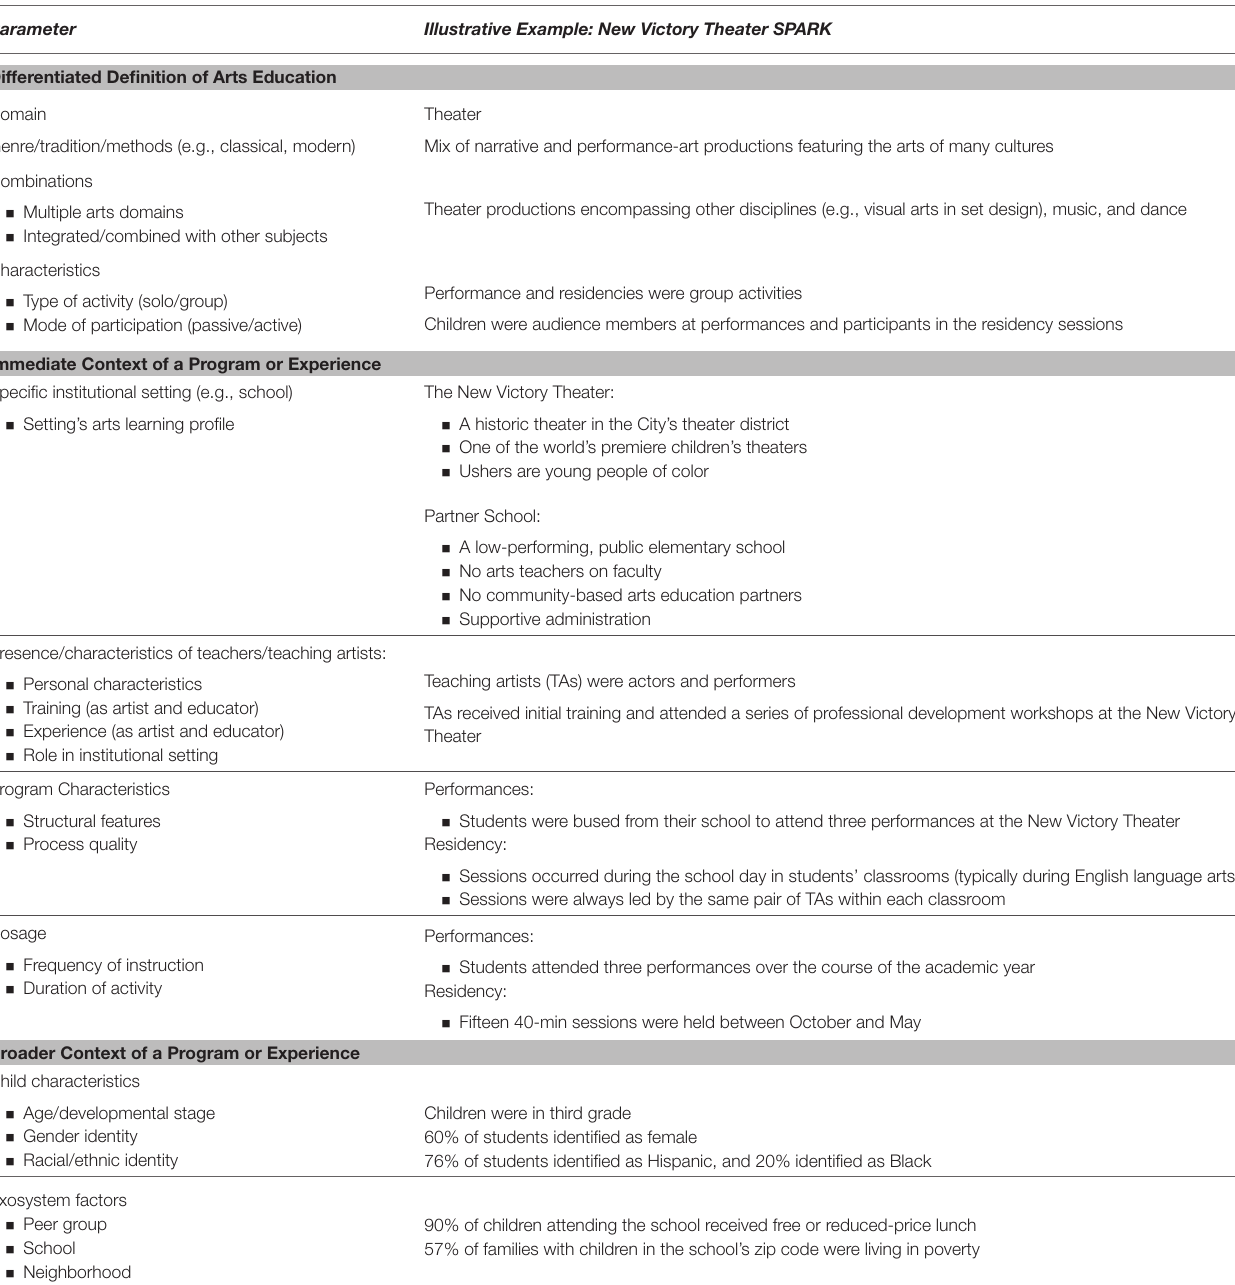
TABLE 1 | Definitional and contextual parameters of an arts education